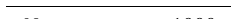
Table 1. Filter thresholds.